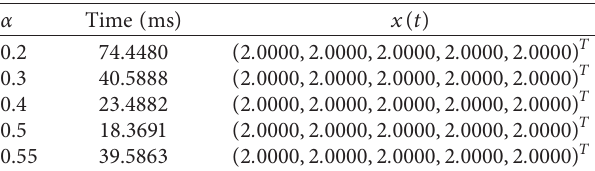
Table 3: Convergence time of x ( t ) by the second-order differential equation system